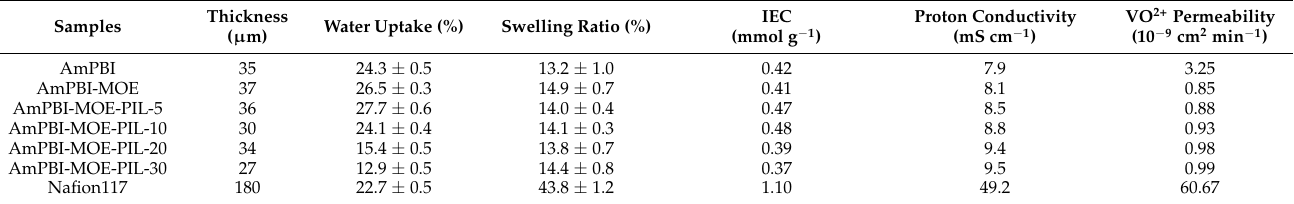
Table 1. Water uptake, proton conductivity, ion exchange capacity, swelling ratio and VO 2+ perme- ability of AmPBI, AmPBI-MOE-PIL-X membranes, and